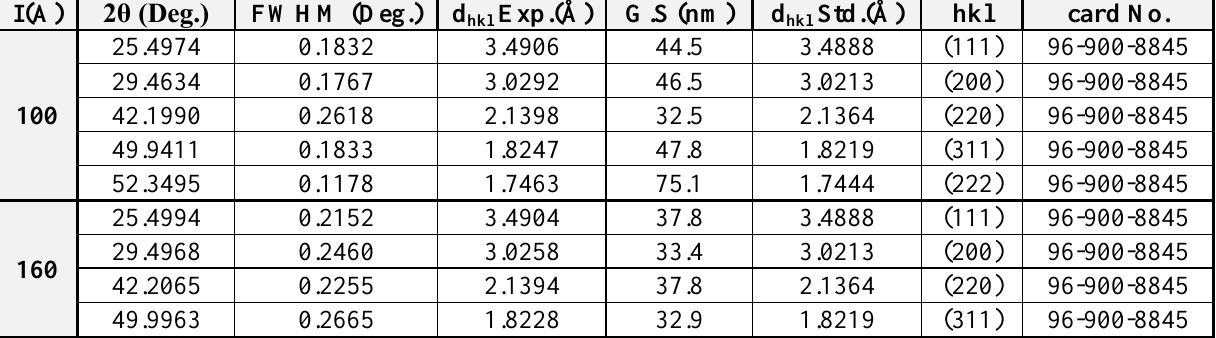
Table 1: XRD parameters for produced CuI nanoparticles using 0.24 mm Cu wire diameter with different currents (100 and 160 A). 2θ